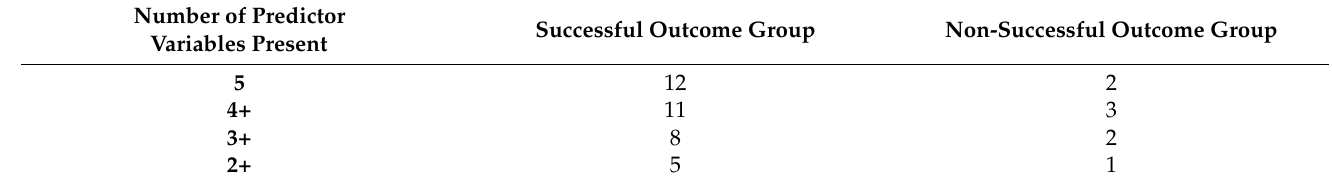
Table 4. The variables for the clinical prediction rule * and the number of subjects in each group at each level †